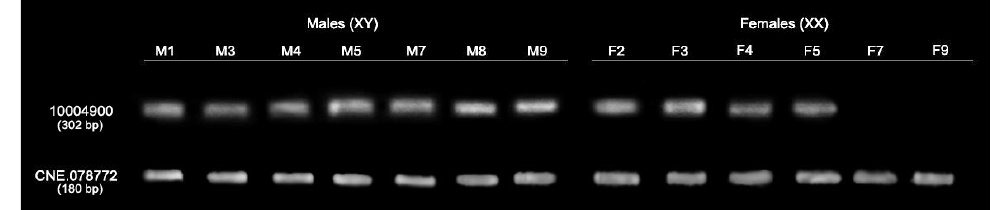
Figure 3. Agarose gel electrophoresis of PCR products in the validation test of sex-linked loci in male and female individuals of Siamese fighting fish ( Betta splendens Regan, 1910) [1].